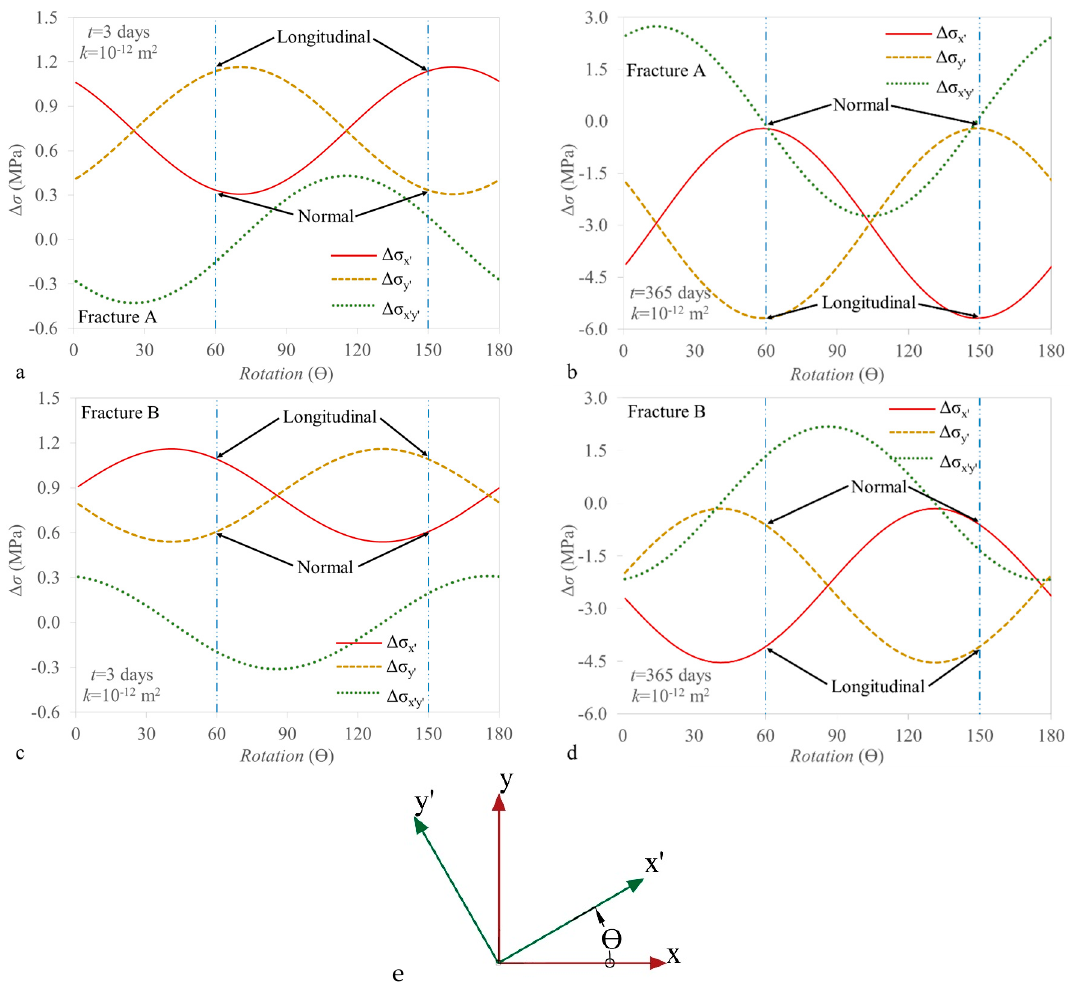
Figure 11. Stress rotations in two points on fractures A and B in response to thermal-hydro-mechanical (THM) effects for intrinsic permeability equal to 10 − 12 m 2 ( a ) for fracture A, after 3 days of injection, ( b ) for fracture A, after 365 days of injection, ( c ) for fracture B, after 3 days of injection, ( d ) for fracture B, after 365 days of injection and ( e ) schematic representation of the reference axes for a rotation angle θ .